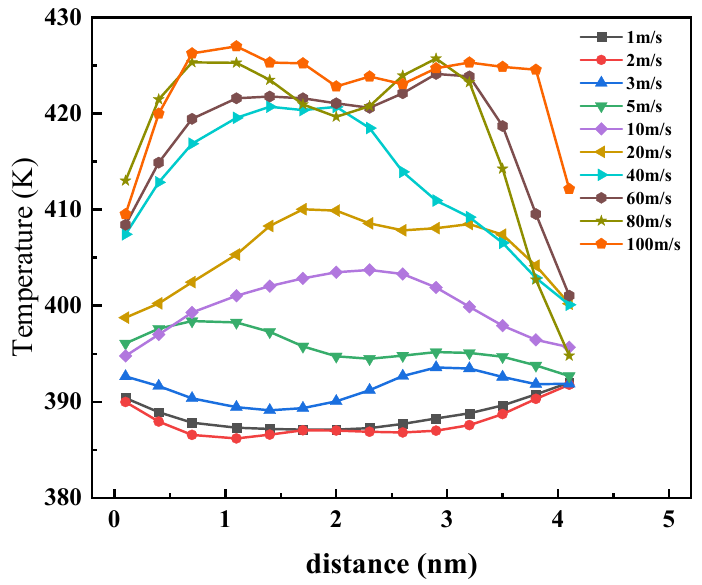
Figure 8. Temperature distribution curves of warm mix asphalt lubricating film under different shear rates.